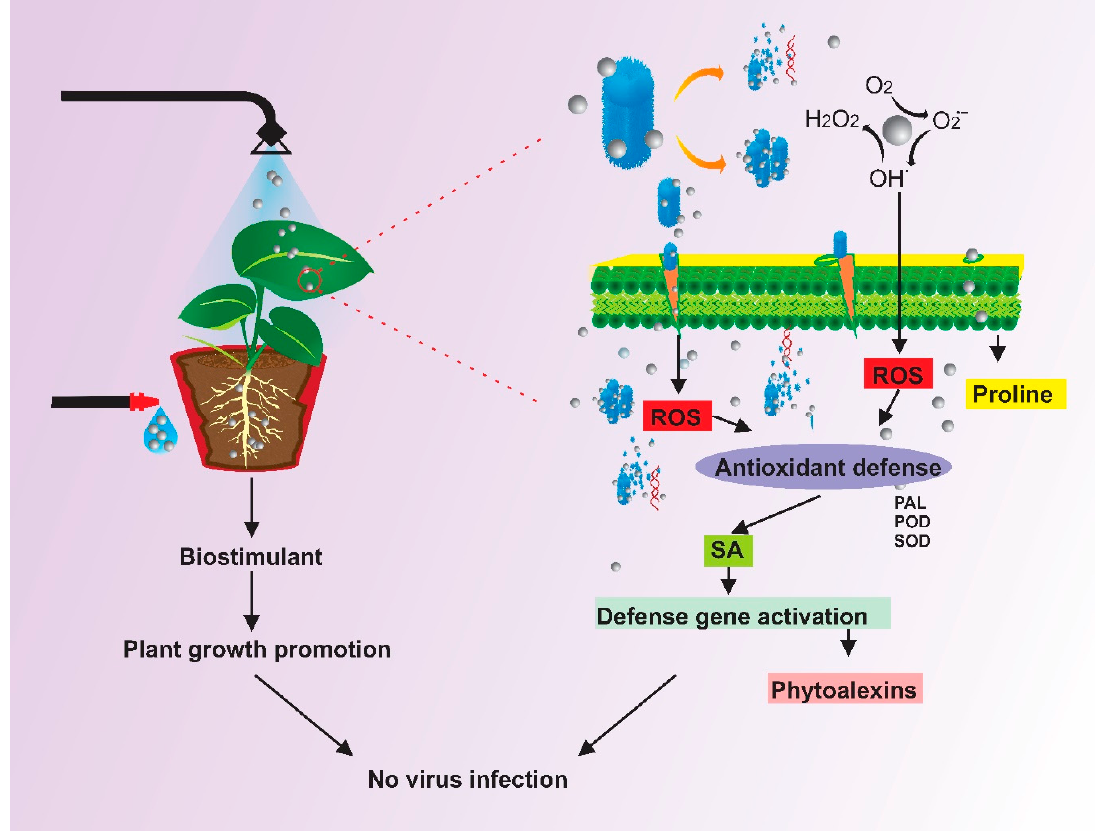
Figure 1. Antiviral mechanism of metal and metal oxide nanoparticles in plants. PAL : phenylalanine ammonia-lyase; POD : peroxidase; ROS : reactive oxygen species; SA : salicylic acid; SOD : superoxide dismutase.